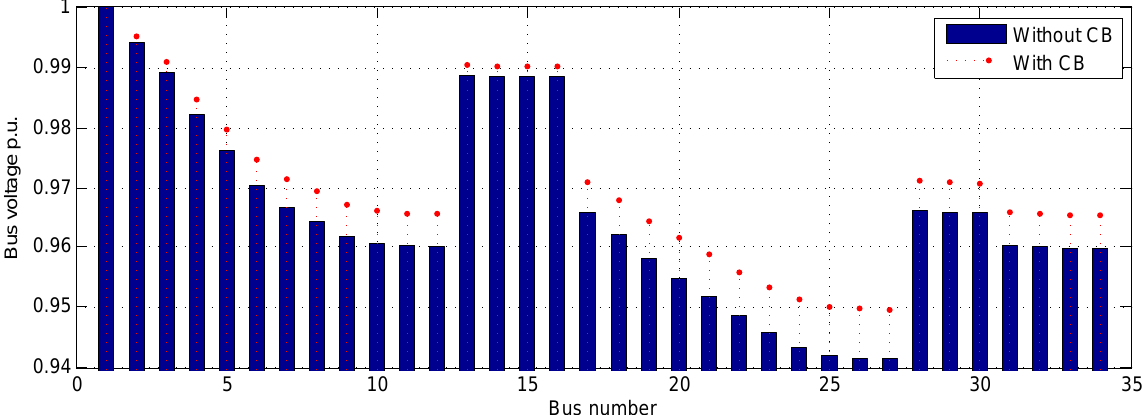
Figure 7. Voltage profile: 34-bus